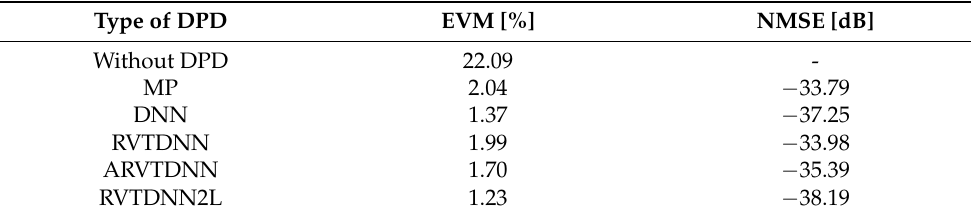
Figure 4. Power Spectral Density of the FC HBF mMIMO using different DPDs. Table 2. Performance of different NN DPD architectures for 64 × 64 FC HBF MIMO system.